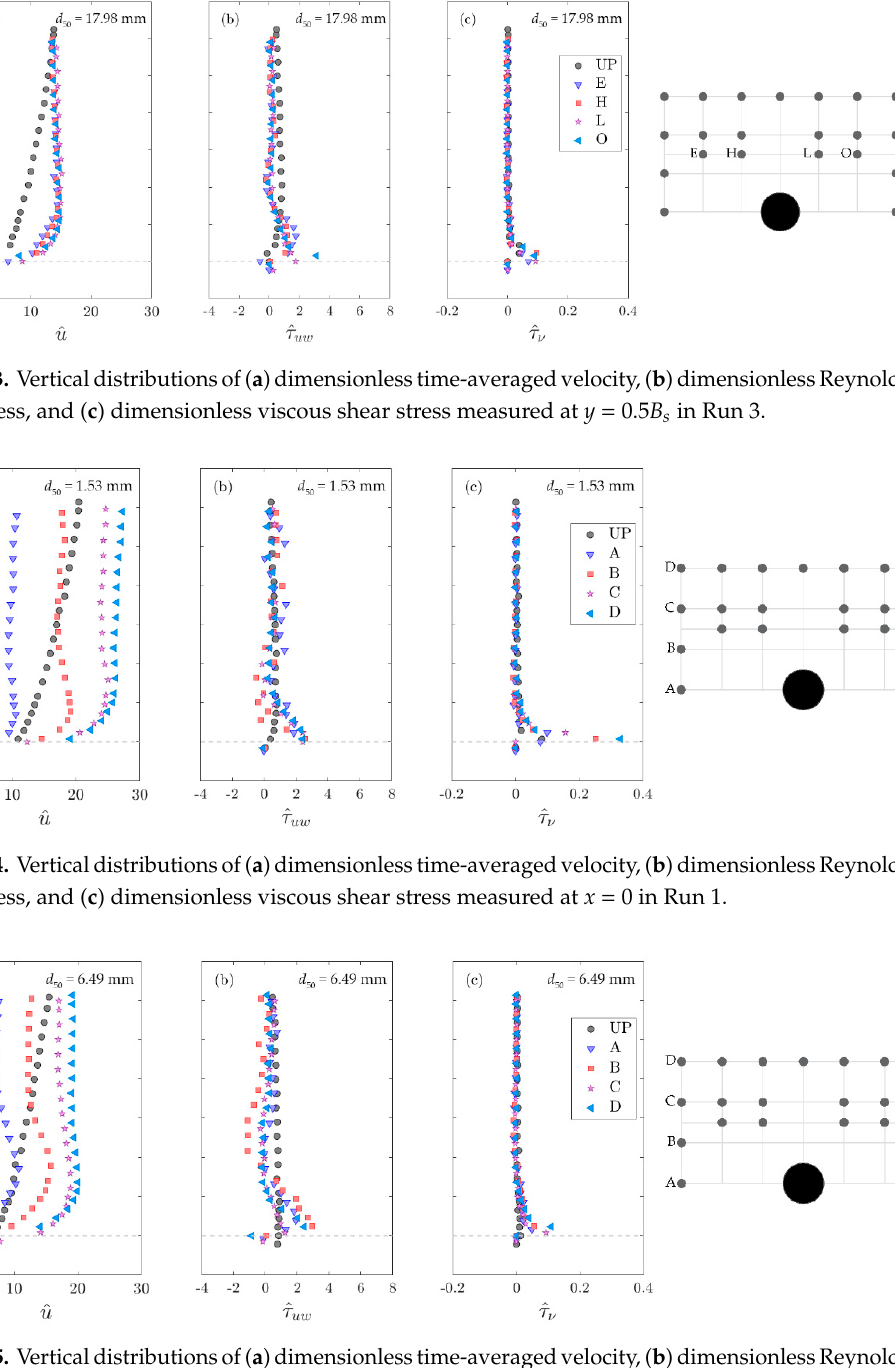
Figure 16. Vertical distributions of ( a ) dimensionless time-averaged velocity, ( b ) dimensionless Reynolds shear stress, and ( c ) dimensionless viscous shear stress measured at x = 0 in Run 3. 5. Energy Spectra The estimation of energy spectra was carried out for the three experimental runs, at several elevations from the bed surface and different locations within the study area. Specifically, Figure 17 shows the energy spectra at the measurement points A and K for Runs 1, 2, and 3 at z = 0.05 h and 0.4 h , respectively. Looking at Figure 17, in the intermediate region ( z = 0.4 h ), the two spectra referred to the measurement points A and K (Figure 17a–c) differ from those measured for the undisturbed profile in all the experimental runs. In fact, the macro-turbulence can be associated to k ≤ 3 × 10 rad m − 1 (for the UP this limit was k ≤ 10 rad m − 1 ). This is the region in which the vegetation stems have a predominant effect on the flow. The discrepancies are more evident between the UP and A signals, regardless of the bed roughness, since the point A lies between two consecutive cylinders in the region of wake vortexes. The inertial subrange is obtained for k > 3 × 10 rad m − 1 , suggesting the presence of meso-scale turbulence. In the near-bed flow region ( z = 0.05 h ), for Run 3 (Figure 17f) at low wave numbers (large scale), all spectra tend to the same constant values, indicating that macro-turbulence is governed by the bed roughness, regardless of the measurement point location within the study area. These spectral peaks are prominent for k ≤ 10 rad m − 1 at the measurement point K and k ≤ 10 2 rad m − 1 at the measurement point A. This implies that the energy production range is extended to smaller scales at point A than at point K, suggesting that the influence of the vegetation stems can be appreciated at small scales in the region of wake vortexes. The same trend is visible in Runs 1 and 2 (Figure 17d,e). Note that all